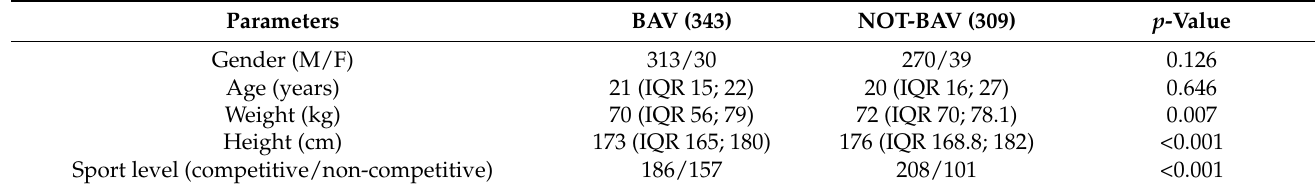
Table 1. Homogeneity test for the main groups’